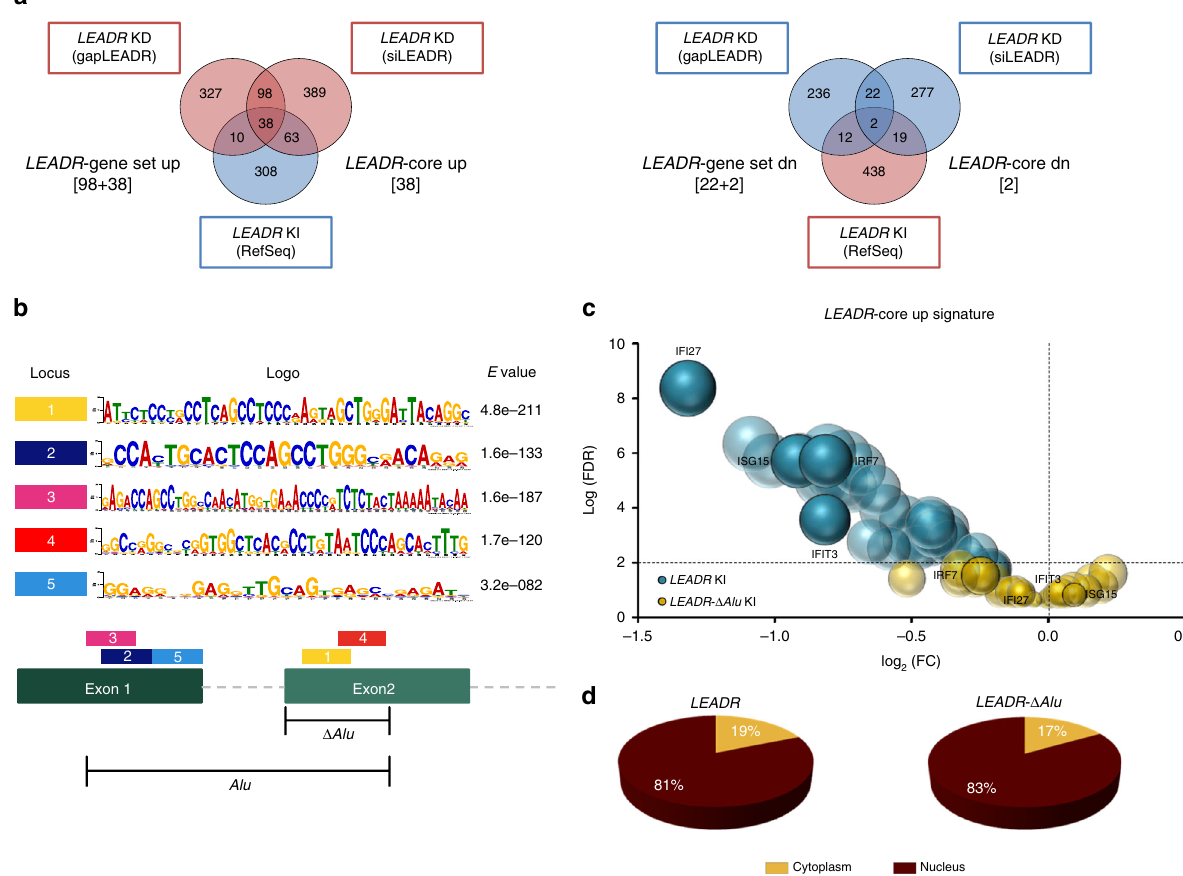
Fig. 7 Alu element in LEADR transcript is essential for its function. a Venn diagram of “ LEADR -gene set up ” signature — i.e., 136 genes upregulated in RWPE-1 cells upon LEADR silencing by two independent approaches ( left ). The subset of 38 genes resulting coherently down-regulated in DU145 cells ectopically overexpressing LEADR is indicated as “ LEADR -core up ” . Venn diagram of the “ LEADR -gene set dn ” signature, composed of the 24 downregulated genes in RWPE-1 cells upon LEADR silencing by two independent approaches ( right ). The subset of two genes resulting coherently upregulated in DU145 cells ectopically overexpressing LEADR is indicated as “ LEADR -core dn ” . b Recurrent motifs (and relative E values) in promoters of “ LEADR -core up ” genes, as from de novo motif discovery ( top ). Alignment of motifs with LEADR transcript is depicted, as well as full Alu /SINE sequence and portion deleted in LEADR- Δ Alu construct ( bottom ). c Bubble plot of “ LEADR -core up ” genes in DU145 cells knocked-in for the wild type ( LEADR KI) or Alu -deleted ( LEADR- Δ Alu KI) LEADR RefSeq transcript. d Pie charts of relative abundance of wild type and Alu -deleted LEADR in the nuclear and cytoplasmic fraction of DU145 cells upon ectopic replacement, as assessed by qRT-PCR. Mean percentage from three and two independent experiments, respectively, is plotted. Source data